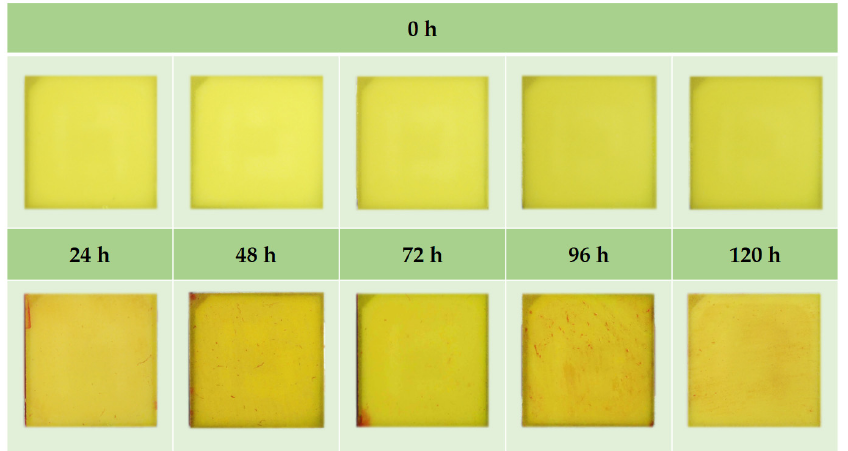
Figure 8. Saturated vapor-pressure test of PiG: appearance of red ink in samples soaked every 24 h.